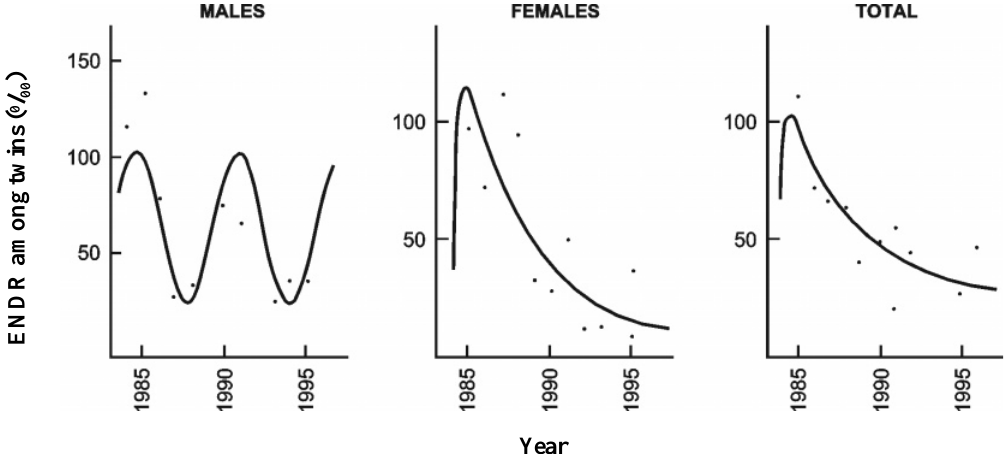
Figure 3 - Best fit regression curves for the annual distribution of the early neonatal death rate (ENDR) among twins born from 1984 to 1996. Males: y = 64.958 + 37.534 sin ( year - 0.038); females: y = 17.835 + 463.984 - 409.236); total sample ( y = 11.185 + 311.950 -